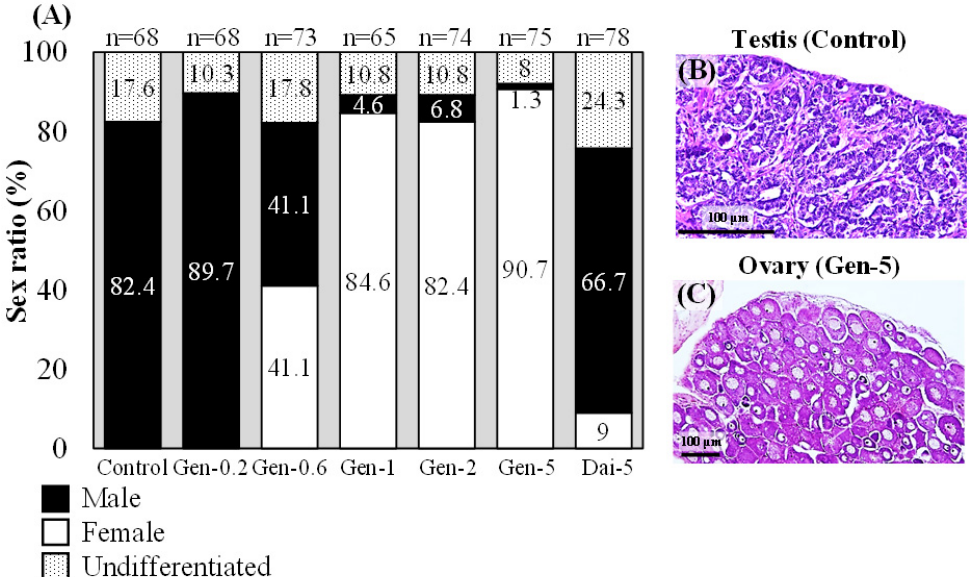
Figure 3. Feminization effects of genistein or daidzein in Japanese eels. ( A ) Sex ratios in eels fed a diet with 0.2, 0.6, 1, 2, or 5 g/kg feed dose of genistein (Gen) or 5 g/kg feed dose of daidzein (Dai). Control, normal diet. ( B , C ) Histological sections of gonads after hematoxylin and eosin staining: control eel testis ( B ) and genistein-treated eel ovary ( C